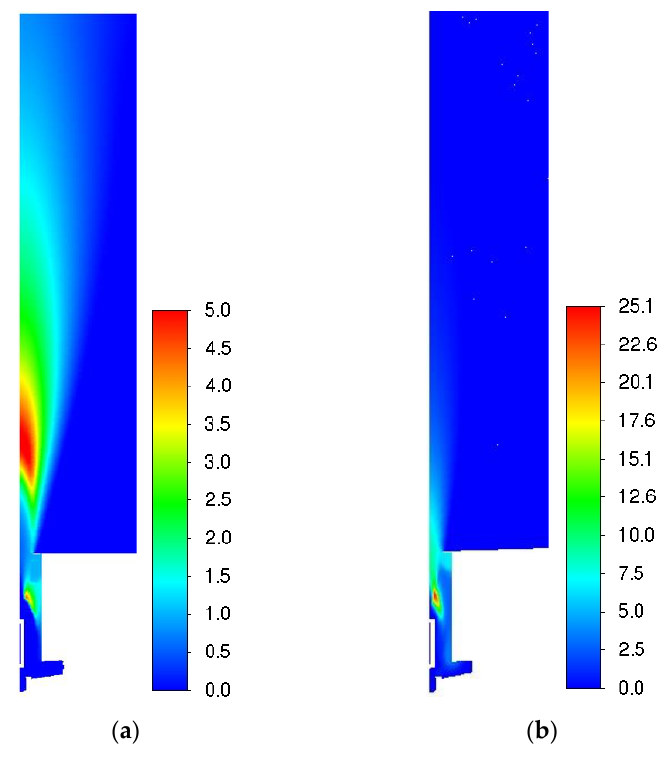
Figure 13. Volume fraction of C 7 H 16 : ( a ) EDC; ( b ) Flamelet-PDF.